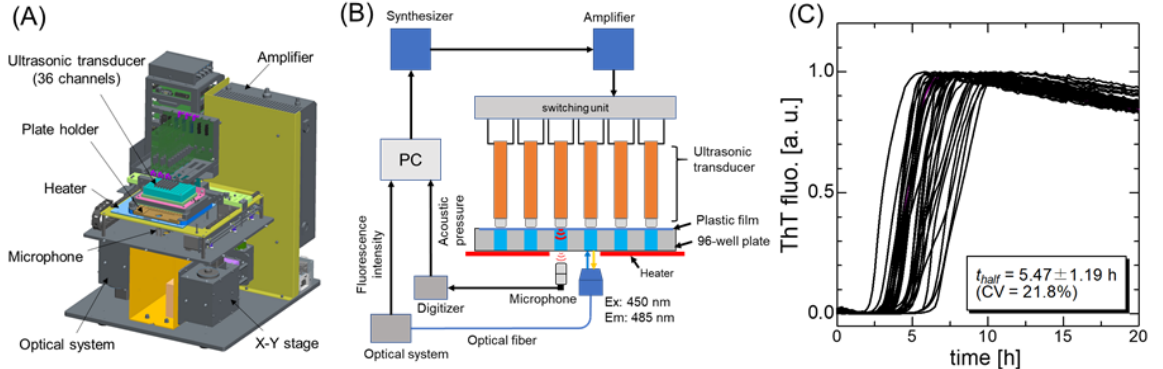
Figure 5. Overview of the HANABI-2000 system. ( A ) A 3D schematic illustration of the optimized sonoreactor for the amyloid-fibril assays, HANABI-2000. The dimensions of the device are 500 × 550 × 550 mm 3 . ( B ) A block chart of the control units of HANABI-2000. The figure is reproduced from Nakajima et al. [98] with permission. ( C ) The ThT time–course curves ( n = 36), which are irradiated with ultrasound with the compensation procedure. The figure was modified from Nakajima et al. [98] with permission. Copyright 2021 Elsevier.